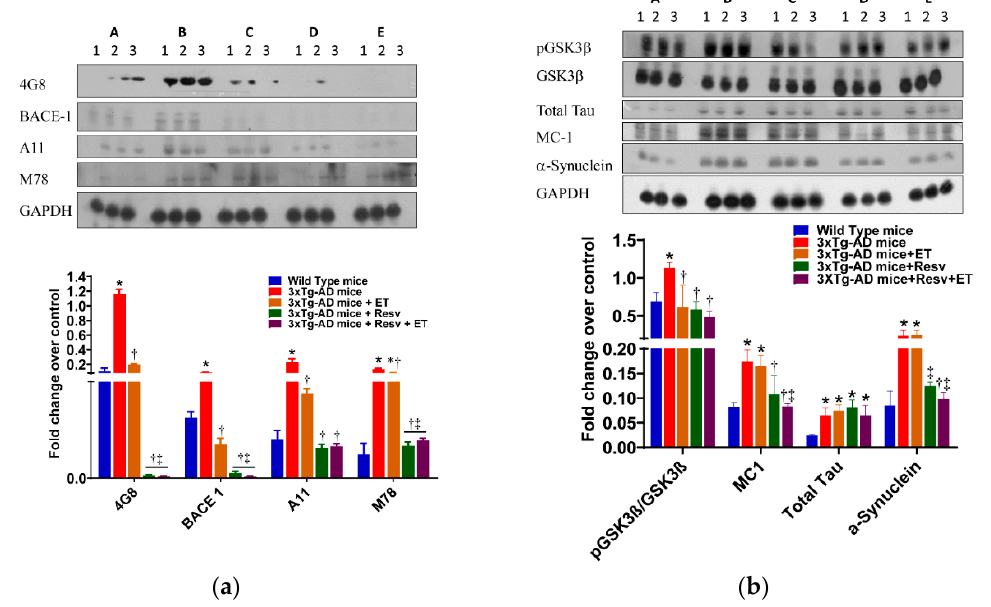
Figure 3. The effects of Resv and ET on conformational toxic species of A β . ( a ) Treating 3xTg-AD mice with Resv or Resv with ET reduces extracellular and intracellular A β accumulation in brain. A β content, oligomers of A β and intracellular A β detected by A11 and M78 antibody. ( b ) Protein content of pGSK3- β was reduced in 3xTg-AD mice treated with Resv, ET, and Resv with ET. Tau oligomers in brain detected by using the MC1 antibody were also reduced with treatment with Resv or Resv with ET but with no change in total tau. Misfolded protein expression levels using α -synuclein antibody were reduced in 3xTg-AD mice treated with Resv or Resv with ET. Corresponding densitometry measurements: A, WT mice; B, 3xTg-AD mice; C, 3xTg-AD mice + ET; D, 3xTg-AD mice Resv;